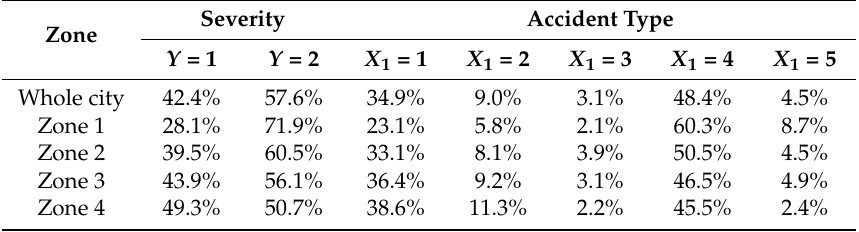
Table 3. Differences of traffic accident type in urban functional zone.